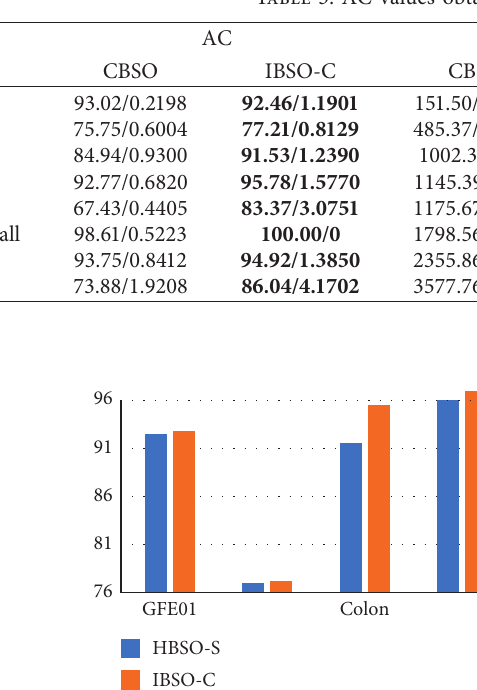
Table 3: AC values obtained by IBSO-C and CBSO.